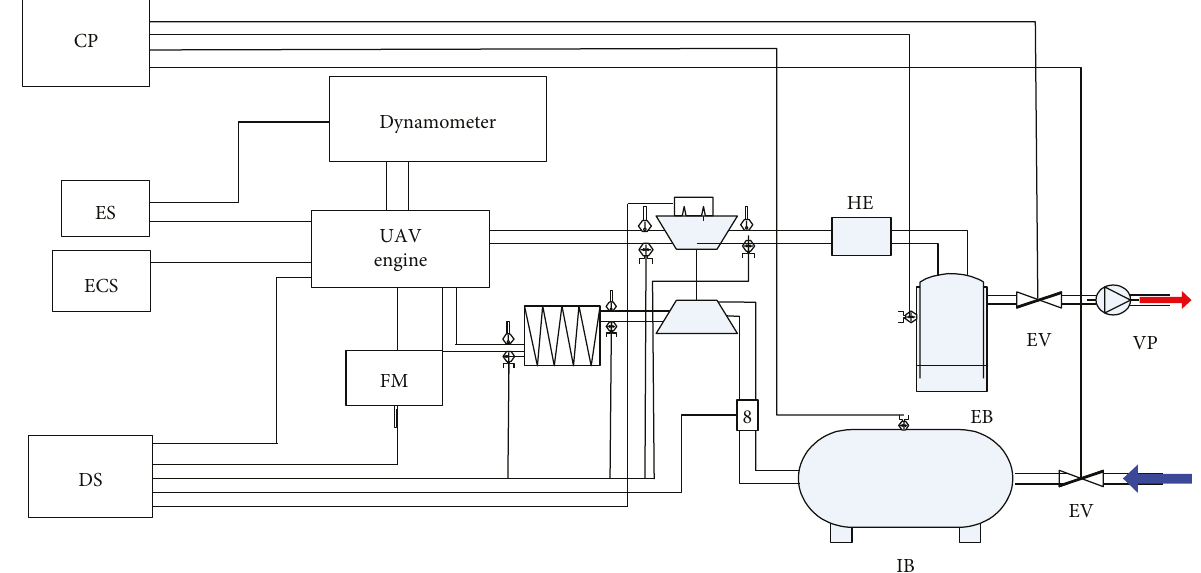
Figure 1: Performance simulation test system for the UAV engine at high altitudes.